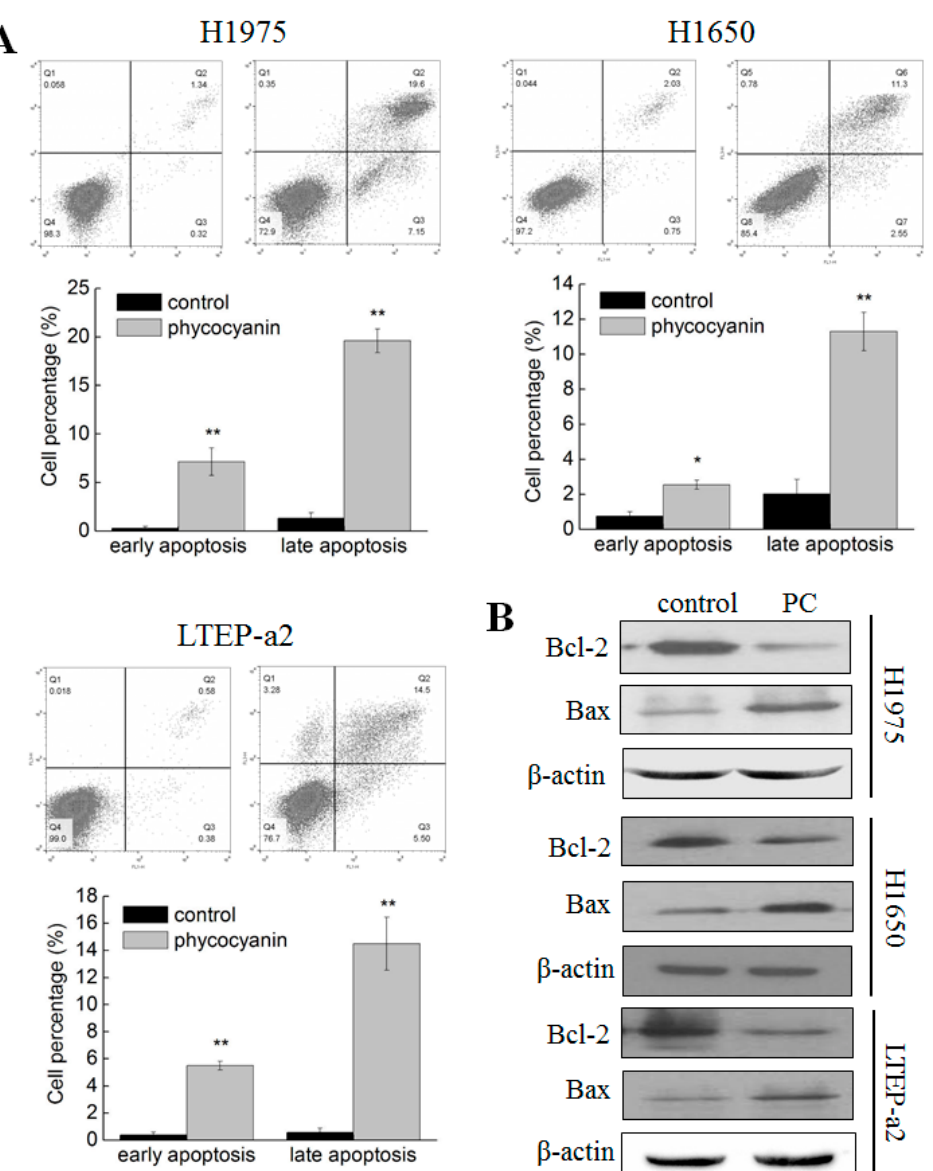
Figure 2. Phycocyanin induced apoptosis of non-small cell lung cancer cells. ( A ) Cell apoptosis analysis of H1975, H1650, and LTEP-a2 cells after treatment with 6 µ M phycocyanin for 48 h. The proportion of early and late apoptotic cells are shown in the histogram. ( B ) Western blot analysis of the expressions of Bcl-2 and Bax in H1975, H1650, and LTEP-a2 cells after treatment with 6 µ M phycocyanin for 72 h. PC, phycocyanin treatment groups. Bars represent mean ± SD. *, p < 0.05; **, p < 0.01.